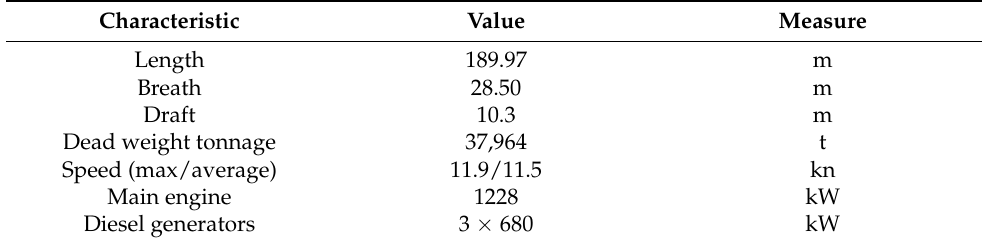
Table 1. Characteristic data of the Handy-size vessel. Characteristic Value Measure Length